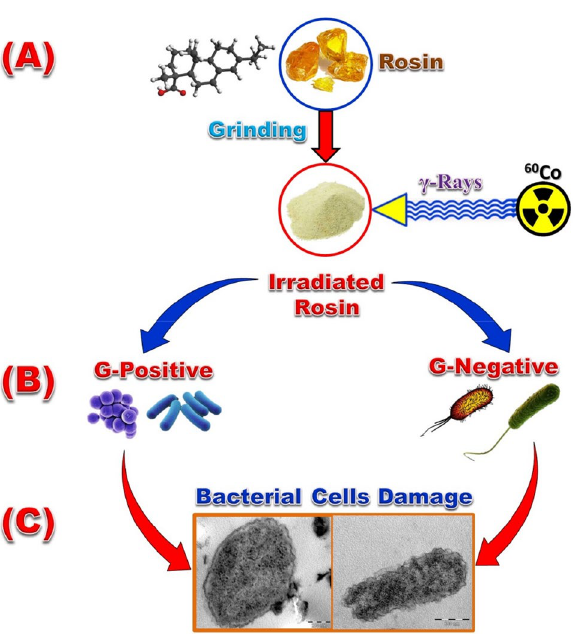
Figure 10. A suggested schematic diagram of ( A ) irradiation of rosin, ( B ) interaction of rosin with different kinds of bacterial and ( C ) cells of bacterial inactivated by disruption of the cell wall and lysis of intracellular constituents DNA, cytoplasm, and